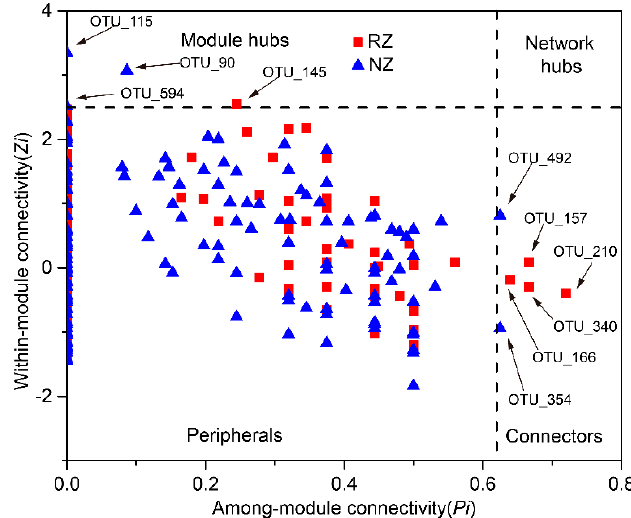
Figure 6. Zi - Pi plots showing distribution of OTUs based on their topological roles in the P. australis zone network (red square) and non- P. australis zone network (blue triangle). Threshold values of Zi and Pi for categorizing OTUs were 2.5 and 0.62. More information on the module hubs and connectors are shown in Table S5. Abbreviations: P. australi zone (RZ); non- P. australis zone (NZ).